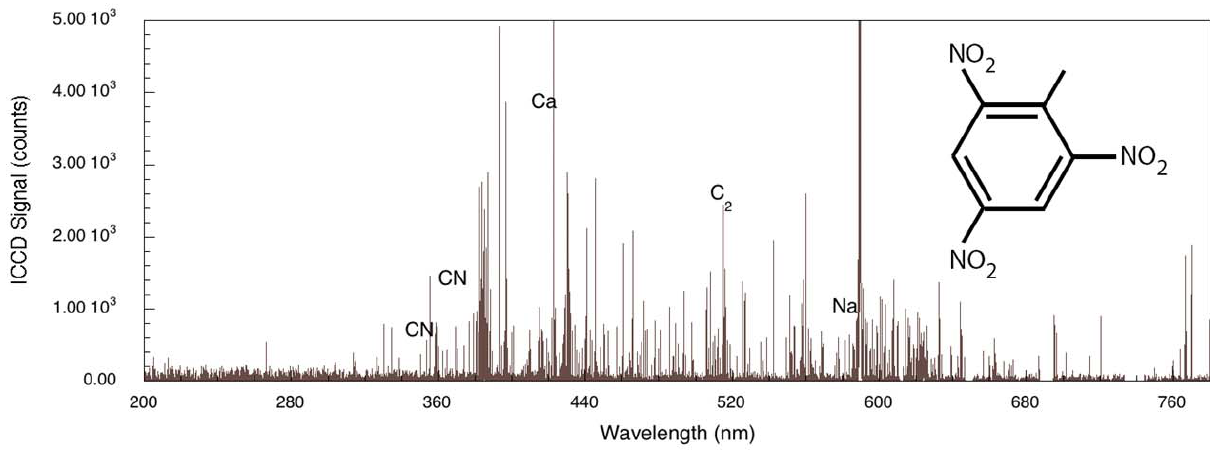
Figure 7. Femtosecond laser excited time-of-flight mass spectrum of polyoxymethylene (light) and of TNT on polyoxymethylene